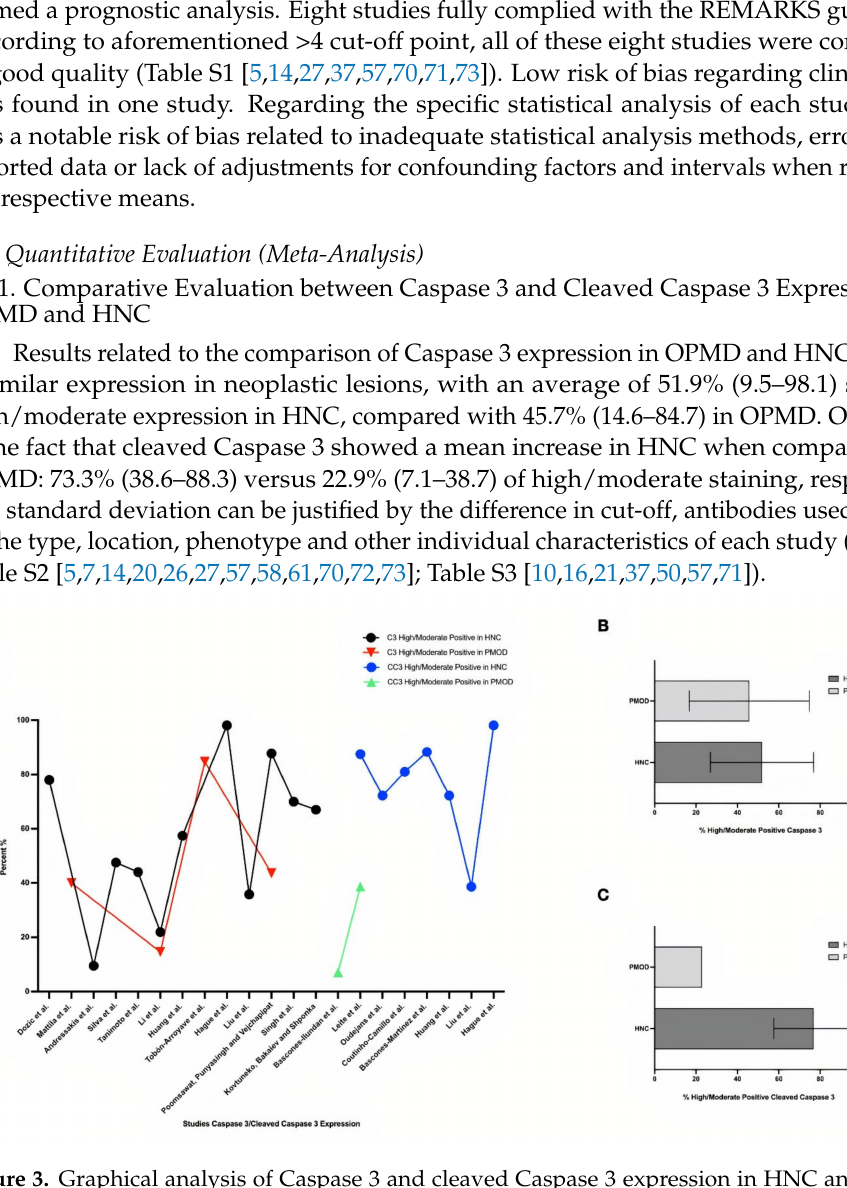
Figure 3. Graphical analysis of Caspase 3 and cleaved Caspase 3 expression in HNC and OPMD. ( A ) In an overview, the studies showed a higher percentage of Caspase 3 and cleaved Caspase 3 in HNC when compared with OPMD; however, the expression of cleaved Caspase 3 was more discrepant. ( B ) Caspase 3 expression showed average values of 51.9% in HNC and 45.7% in OPMD. ( C ) Cleaved Caspase 3 was 73.3% in HNC and 22.9% in OPMD